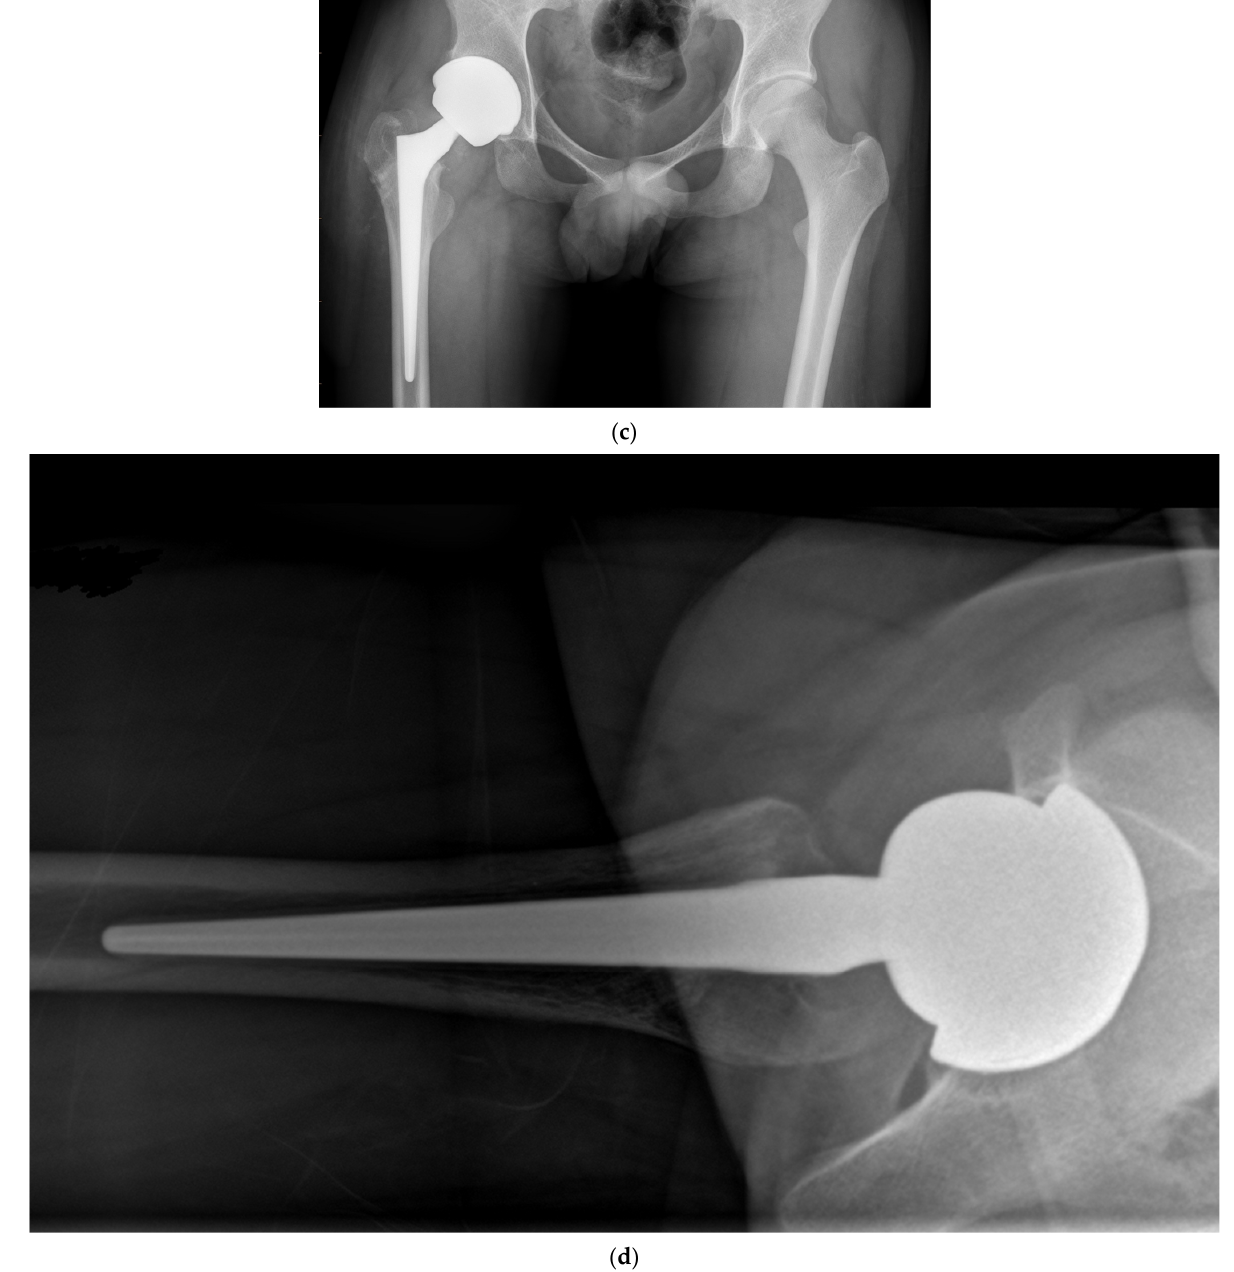
Figure 1. ( a ) Anteroposterior pelvis radiograph of 19-year-old men with right femoral head avascular necrosis following a slipped capital femoral epiphysis treated with canulated screws. During preoperative templating, acetabular, and femoral components sizes were estimated to be small. ( b ) Preoperative lateral view of the right hip. ( c ) Postoperative anteroposterior pelvis radiograph showing a CoC LDH THA with a 13 mm conical stem and a 46 mm monobloc ceramic acetabular com- ponent with a bearing diameter of 36 mm. ( d ) Postoperative lateral view of the right hip replacement. 3. Two Types of Large Diameter Head THA Are Reviewed in This